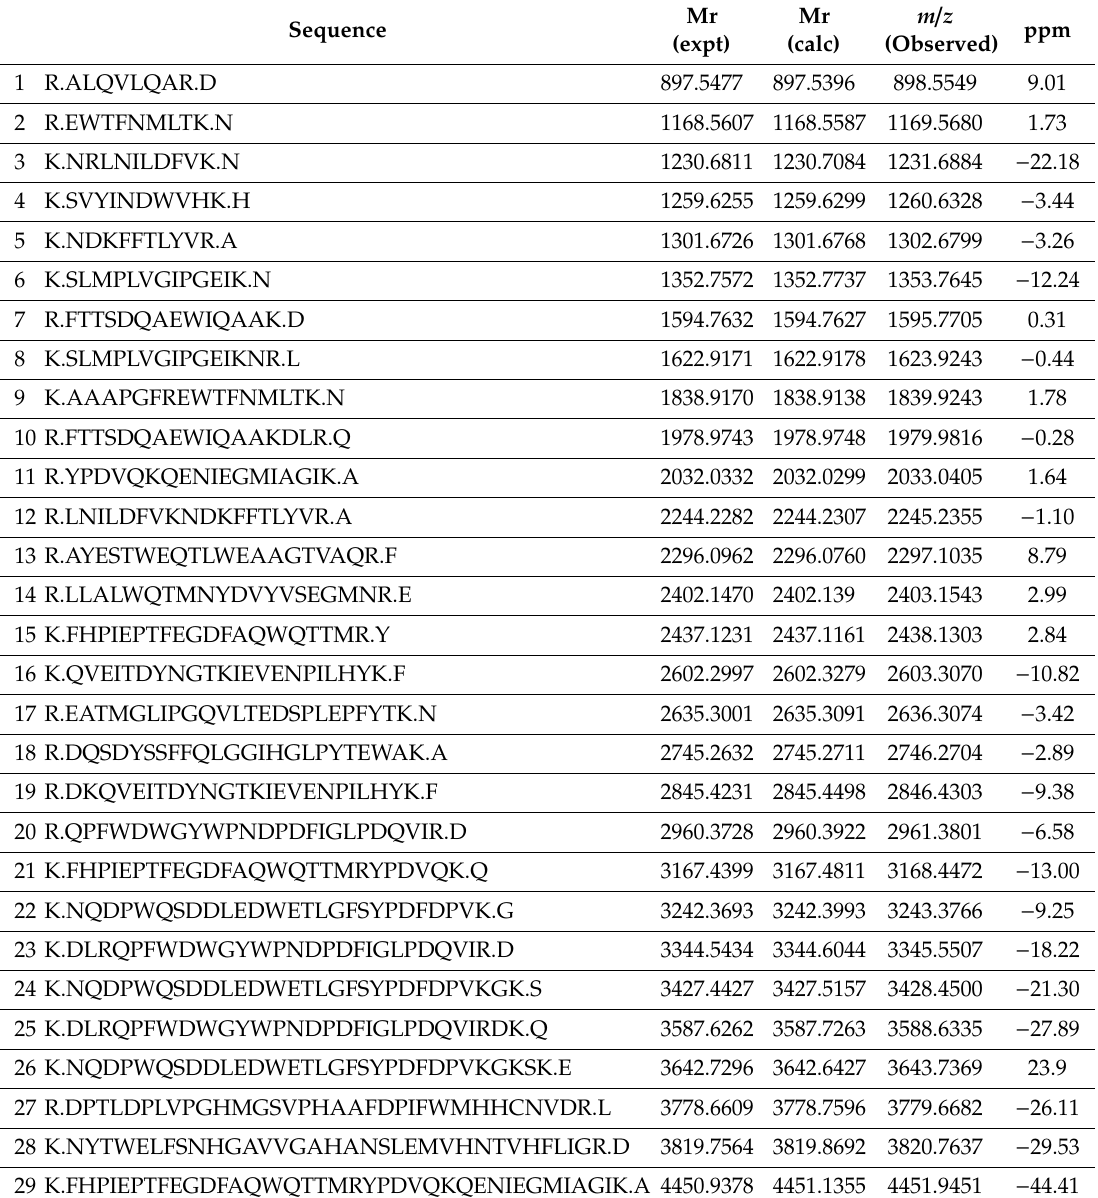
Table 2. List of peptides matches found by MALDI TOF / TOF MS measurements (protein spots tryptic digest of the Area 1 on the electrophoregram, Figure